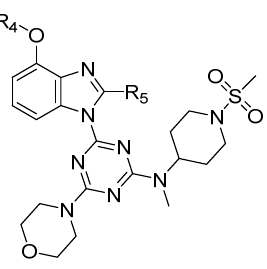
Figure 7. The structure of the designed compounds based on the template compound 29 .